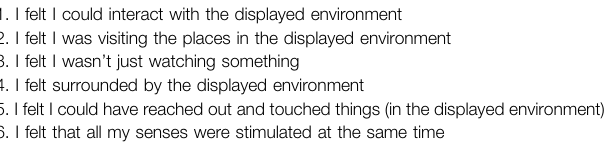
TABLE 1 | Items of the short spatial presence